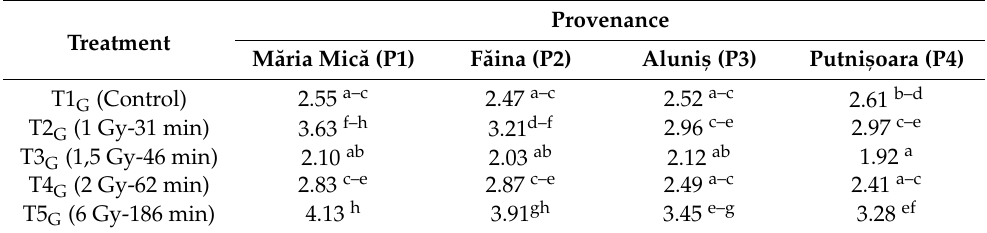
Table 4. The seedling’s height (cm) depending on the interaction between G treatment and provenance. Treatment